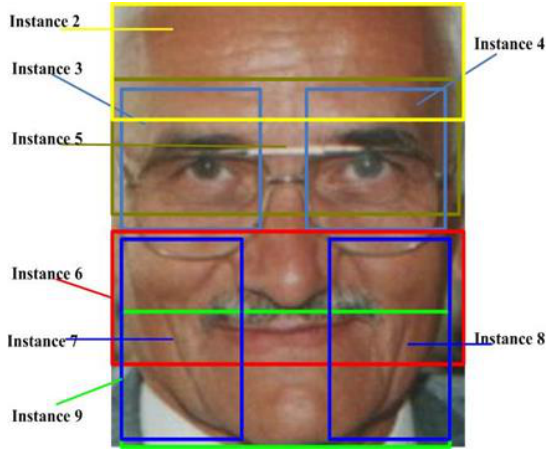
Figure 3. Facial gender and age instances in a face image.